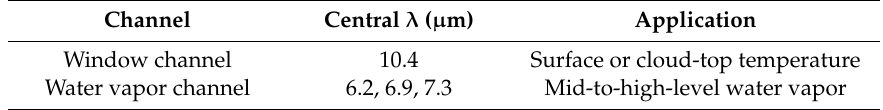
Table 1. Characteristics of the four Himawari-8 infrared channels used in the present